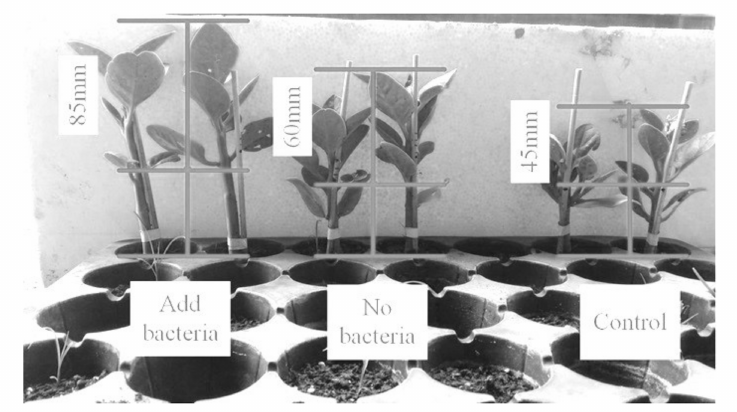
Figure 15. Differences in plant growth of fermented fertilizer results compared with control group, no bacteria group, and added bacteria